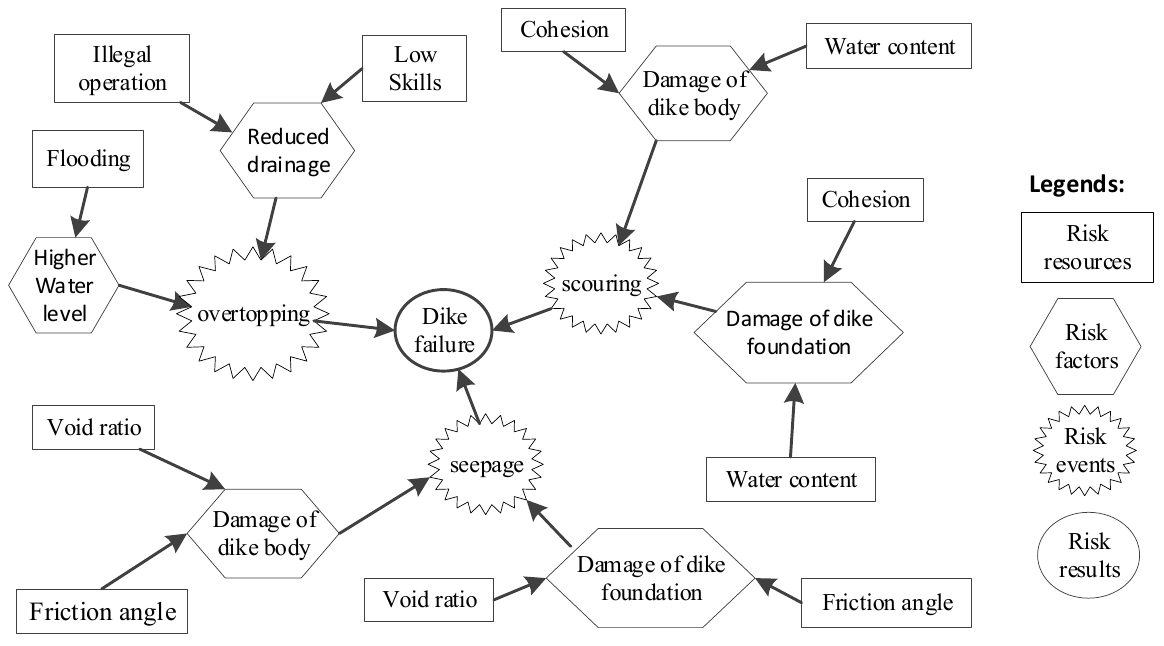
Figure 2. The fuzzy diagram.